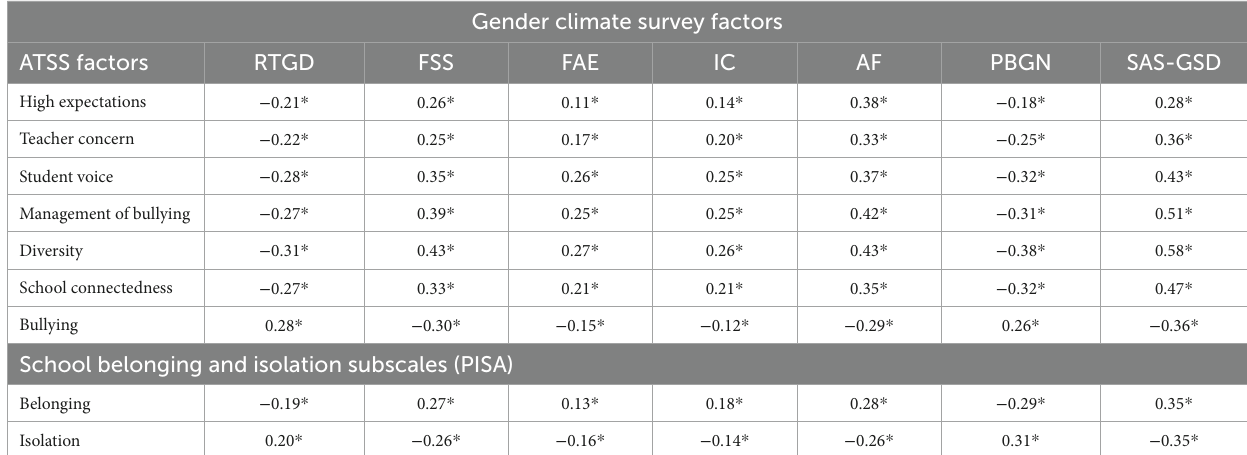
TABLE 4 Bivariate correlations between factors of the ATSS/PISA and the gender climate survey.